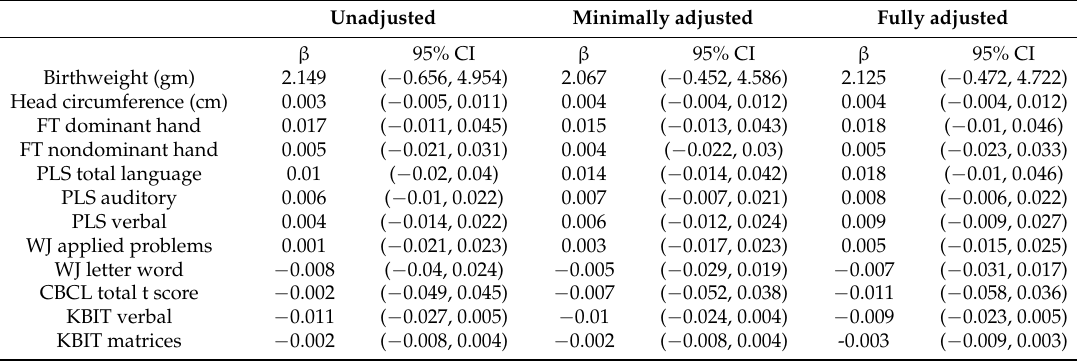
Table 3. Slopes ( β ) and 95% confidence intervals (95% CI) relating 25(OH)D concentrations at delivery to birth outcomes and neurocognitive outcomes at 5 years of age 1